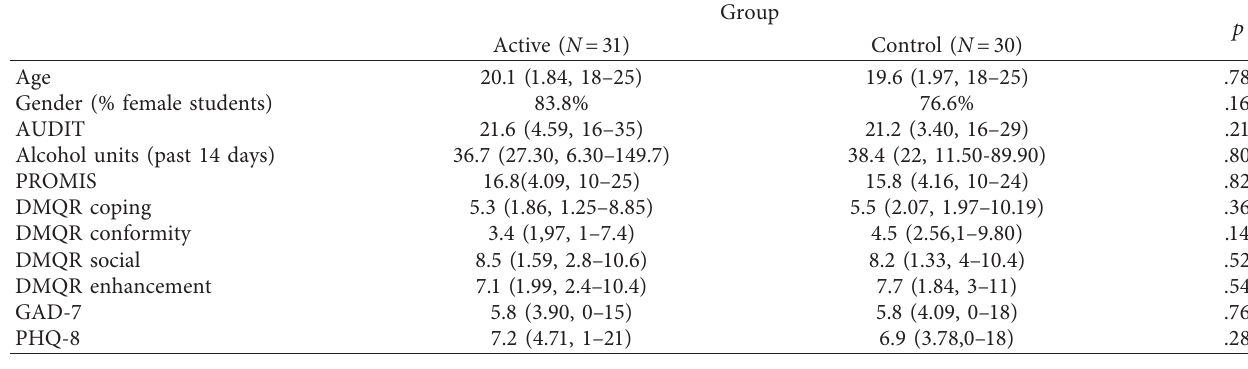
Table 1: Mean (SD, range) of questionnaire data reported by the active intervention and control groups. AUDIT � Alcohol Use Disorder Identification Test. PROMIS � Patient-Reported Outcomes Measurement Information System Alcohol Use Short Form. DMQR � modified Drinking Motives Questionnaire Revised. GAD � Generalised Anxiety Disorder test. PHQ � Patient Health Questionnaire depression scale. p � significance level of the group contrast.